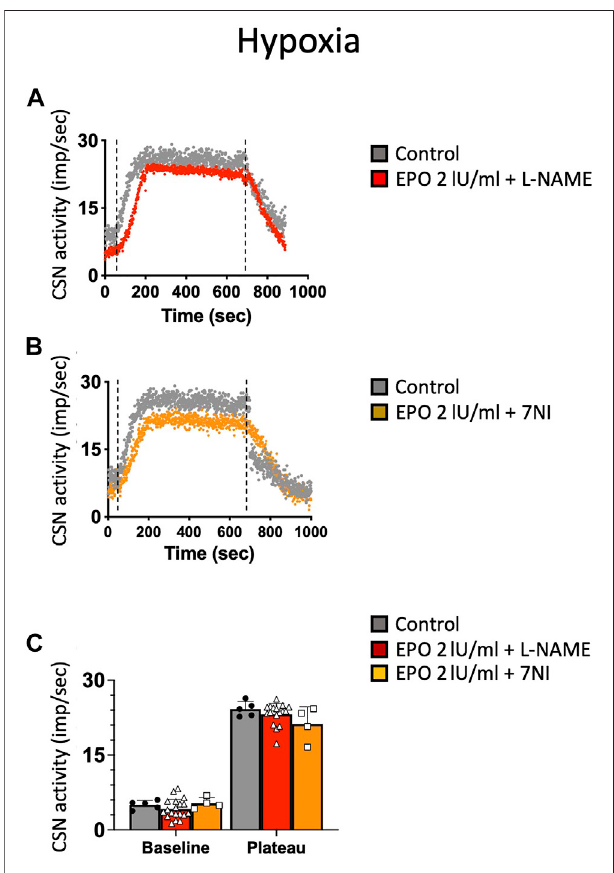
FIGURE 5 | (A) Non-speci fi c (L-NAME) and (B) neuronal-speci fi c (7Ni) inhibitors of NOS prevented EPO-mediated inhibition of carotid sinus nerve (CSN) hypoxic activity at a concentration of 2 IU/ml (C) RM Two-way ANOVA F(2,23) (cid:1) 2.11 p (cid:1) 0.144.Dashedlinesindicatethebeginningandendof the hypoxic